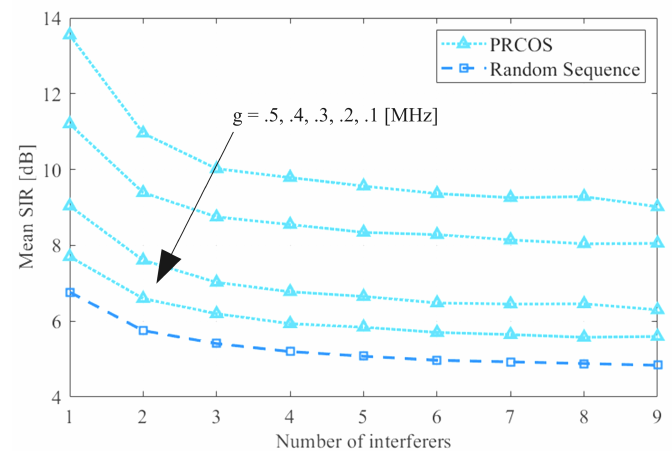
Figure 10. Simulation results of comparing the mean SIR for nine interferers using the PRCOS and random sequence; parameters are described in Table 4.